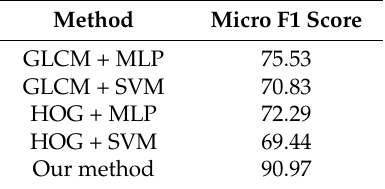
Table 11. Performance of classification using different methods.